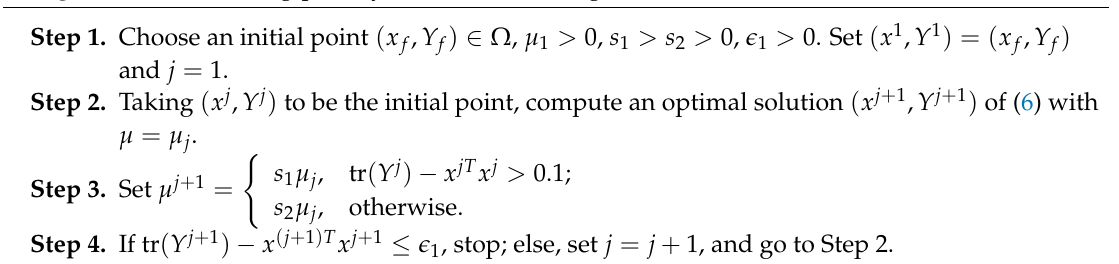
Algorithm 1: The lifting-penalty method for solving (1)